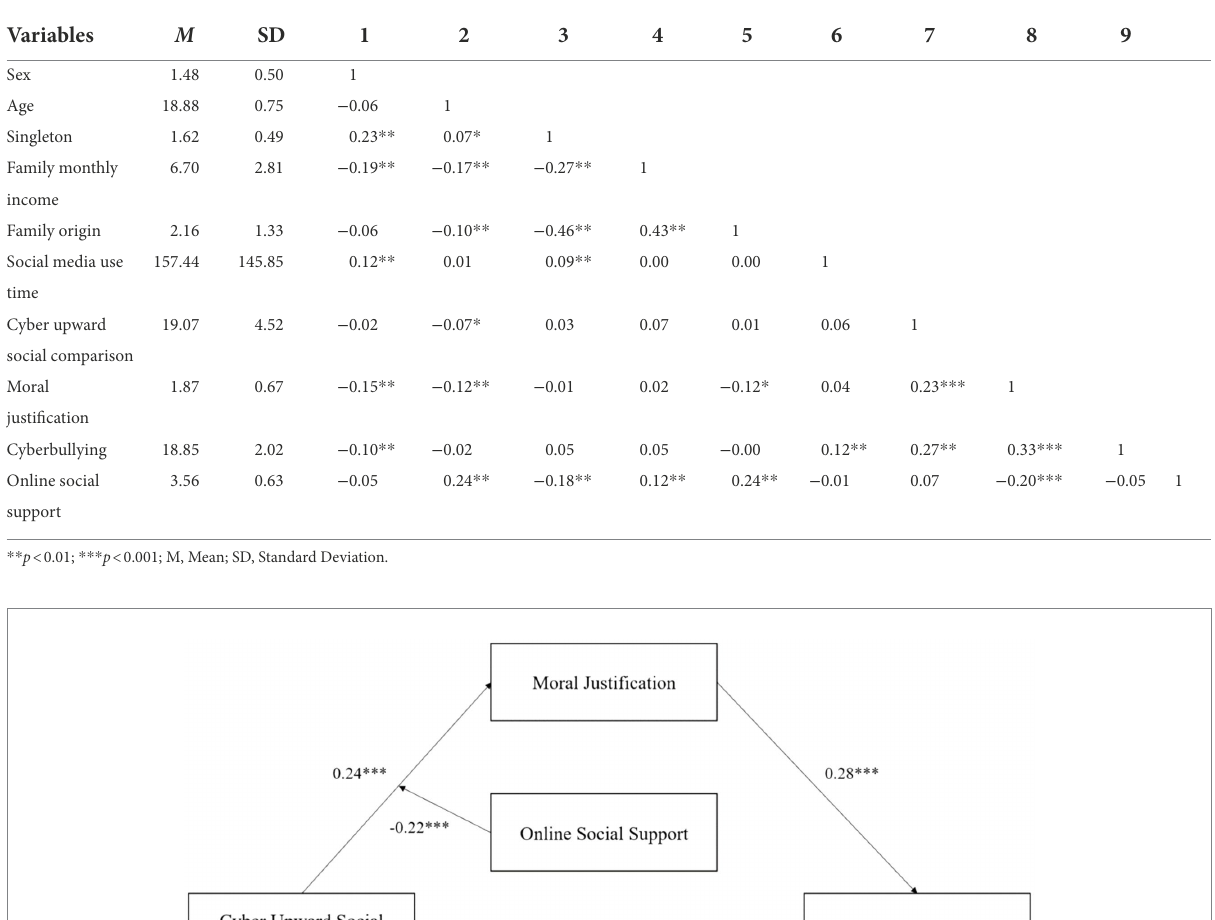
TABLE 3 Descriptive statistics of each variable and correlation matrix.